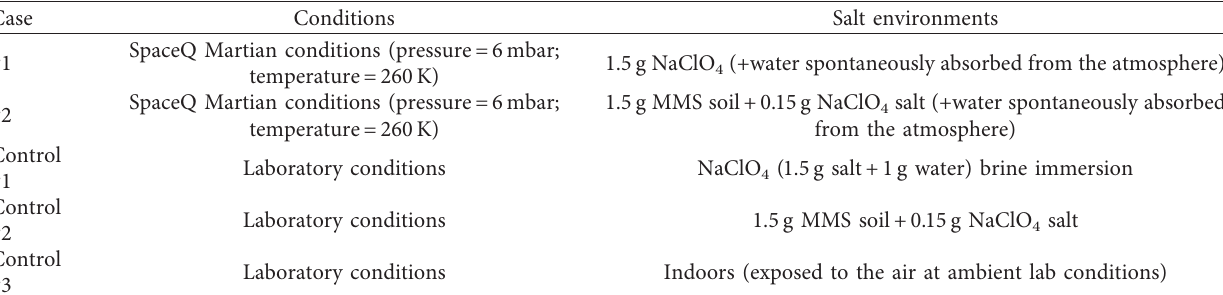
Table 1: Environmental conditions of the experiments performed with 11R51, SS4301, and